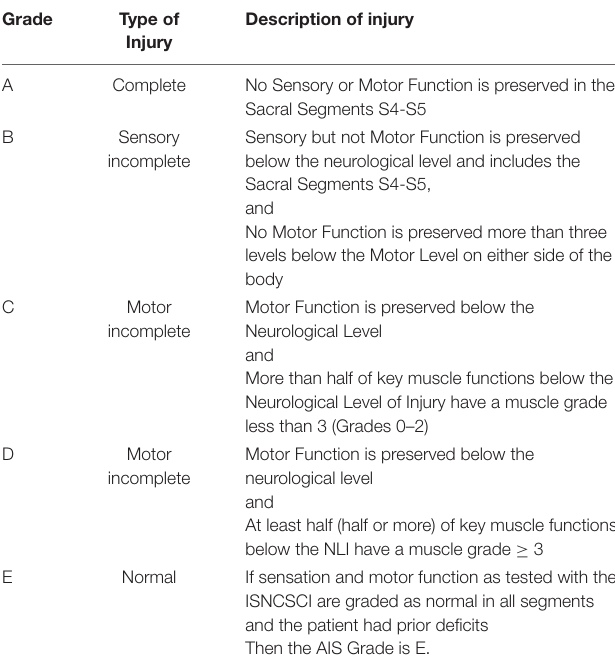
TABLE 1 | American Spinal Cord Injury Association impairment scale